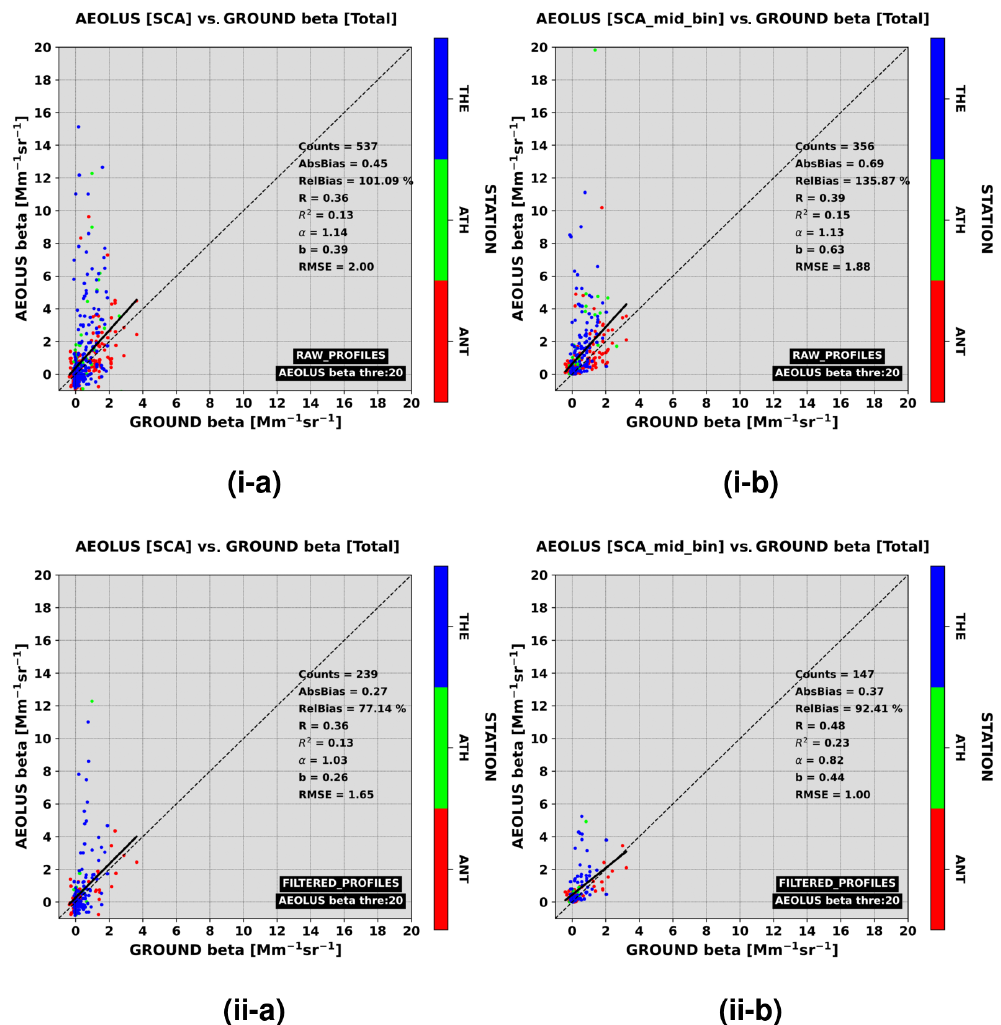
Figure 7. Scatterplots between Aeolus ( y axis) and ground-based ( x axis) backscatter coefficient retrievals resolved based on the indices of Aeolus vertical bins (coloured circles). In the upper (i) and lower (ii) panels, the results for the unfiltered and filtered Aeolus profiles are depicted, respectively. In the left and right columns, the results corresponding to Aeolus regular (24 bins) and mid-bin (23 bins) vertical scales are illustrated, respectively. Aeolus backscatter values larger than 20Mm − 1 sr − 1 are masked out from the collocated sample.